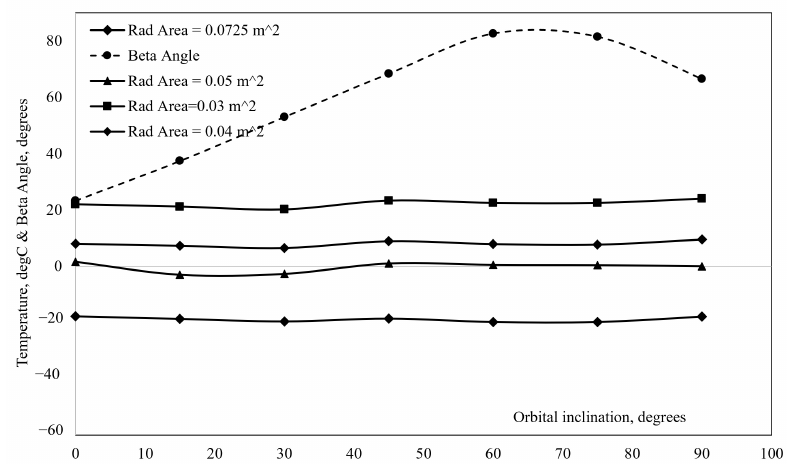
Figure 25. DR temperature variation with inclination and beta angle—Worst cold